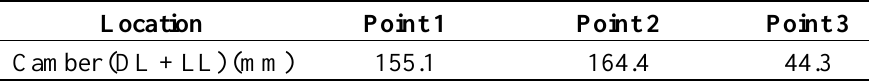
Table 3. Camber of each measurement